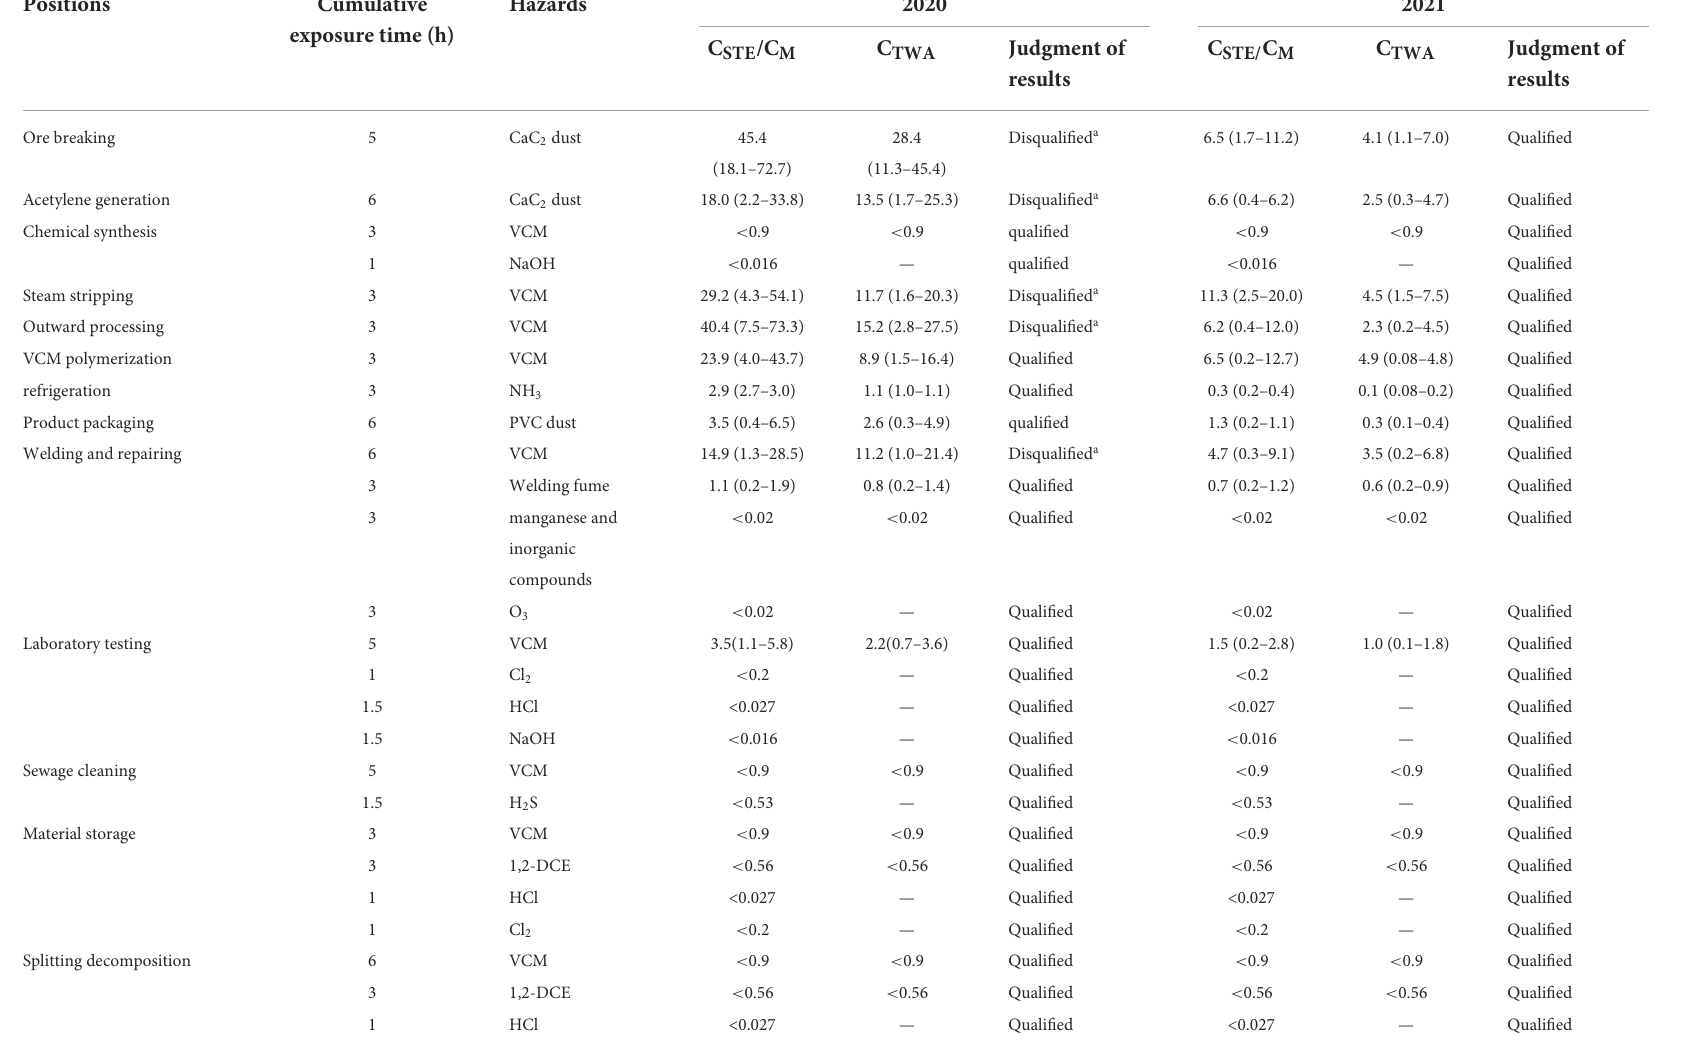
TABLE 3 Results of hazards detection before and after improvements in protective measures. Positions